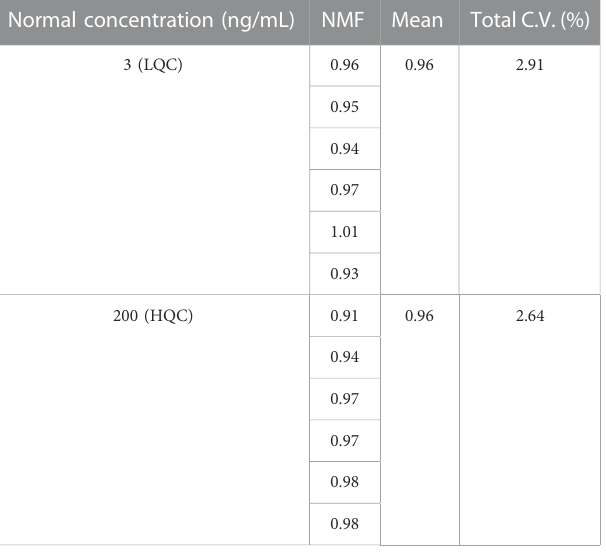
TABLE 2 Matrix effect test results. Normal concentration